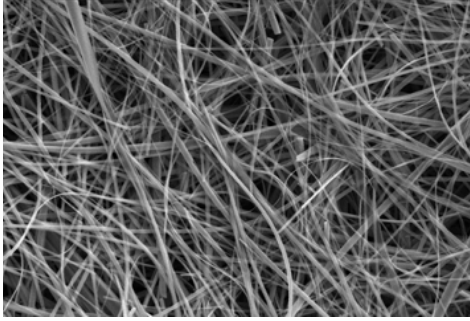
Figure 14. SEM image of ( perylene )